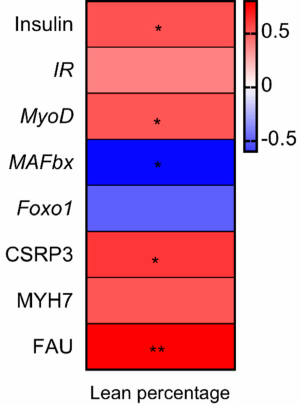
Figure 4. Heatmap of Pearson’s rank correlation coe ffi cients between the relative abundance of genera, ADG, bacterial metabolites and intestinal genes expression. In the panels, * p < 0.05 and ** p < 0.01. IR , insulin receptor; MyoD , myoblast determination protein; MAFbx, muscle atrophy F-box; Foxo1, forkhead Box O1; FAU, 40S ribosomal protein S30; MYH7, myosin-7; CSRP3, cysteine and glycine-rich protein